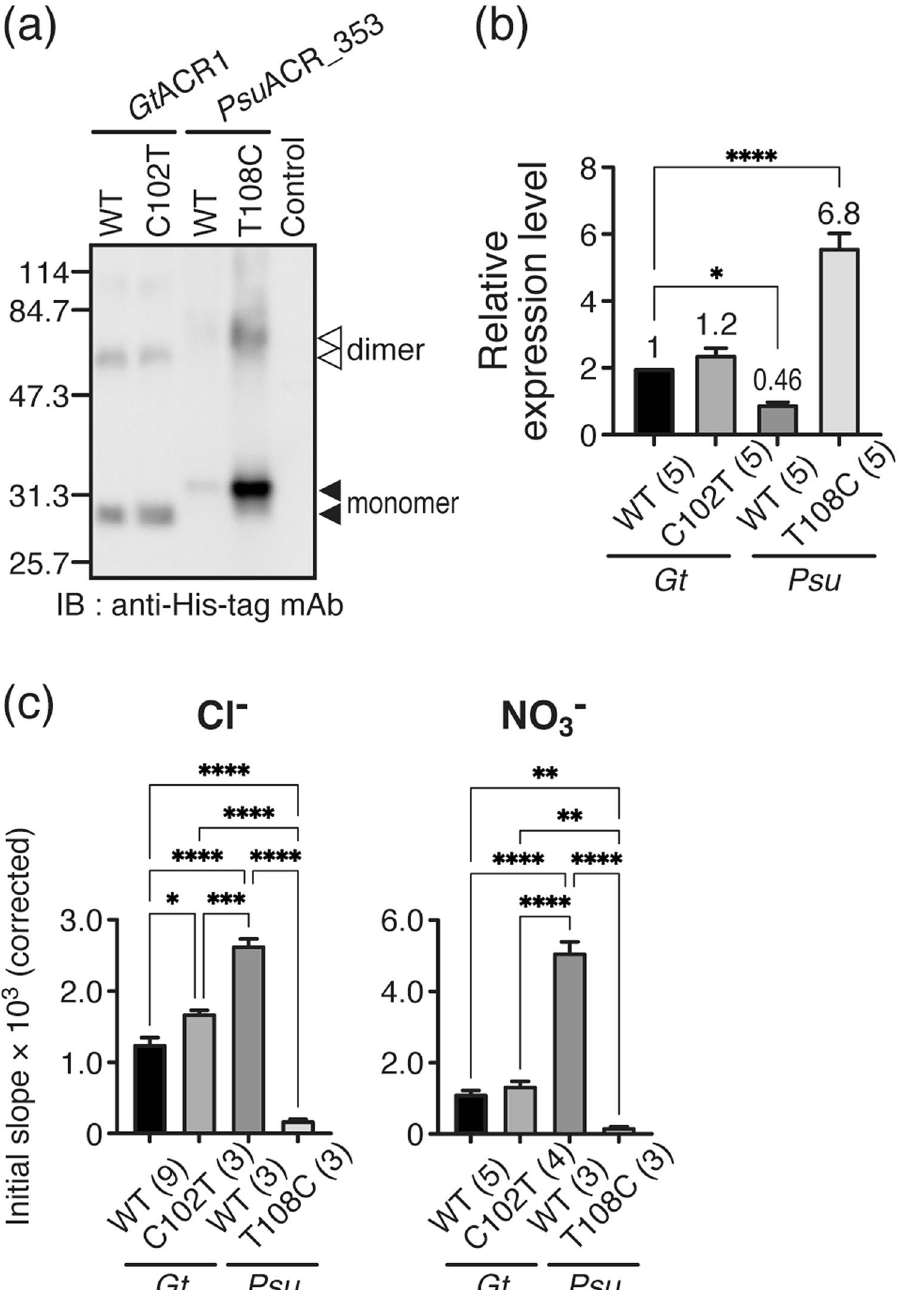
Figure 5. Quantitative comparisons of the anion transport activities of Gt ACR1, Psu ACR_353 and their mutants. ( a ) Western blotting using anti-His-tag mAb after SDS-PAGE; each ACR has monomer and dimer bands as indicated by filled and open triangles, respectively. The sum of band intensities was used to estimate protein expression levels. Original image of full-length membrane was shown in Supplementary Figure S5. ( b ) Statistical comparisons of relative expression levels. Data are reported as means and S.E.M.; the numbers in parentheses indicate the number of independent experiments. One-way ANOVA followed by Dunnett’s test was performed ( p values; **** < 0.0001, * 0.0124). ( c ) Statistical comparisons of the transport activities of Cl − (left) and NO 3 − (right). Data were corrected by the relative expression level and are reported as means and S.E.M.; the numbers in parentheses indicate the number of independent experiments. One-way ANOVA followed by Tukey’s test was performed ( p values; **** < 0.0001, *** < 0.0007, ** < 0.0049, * <